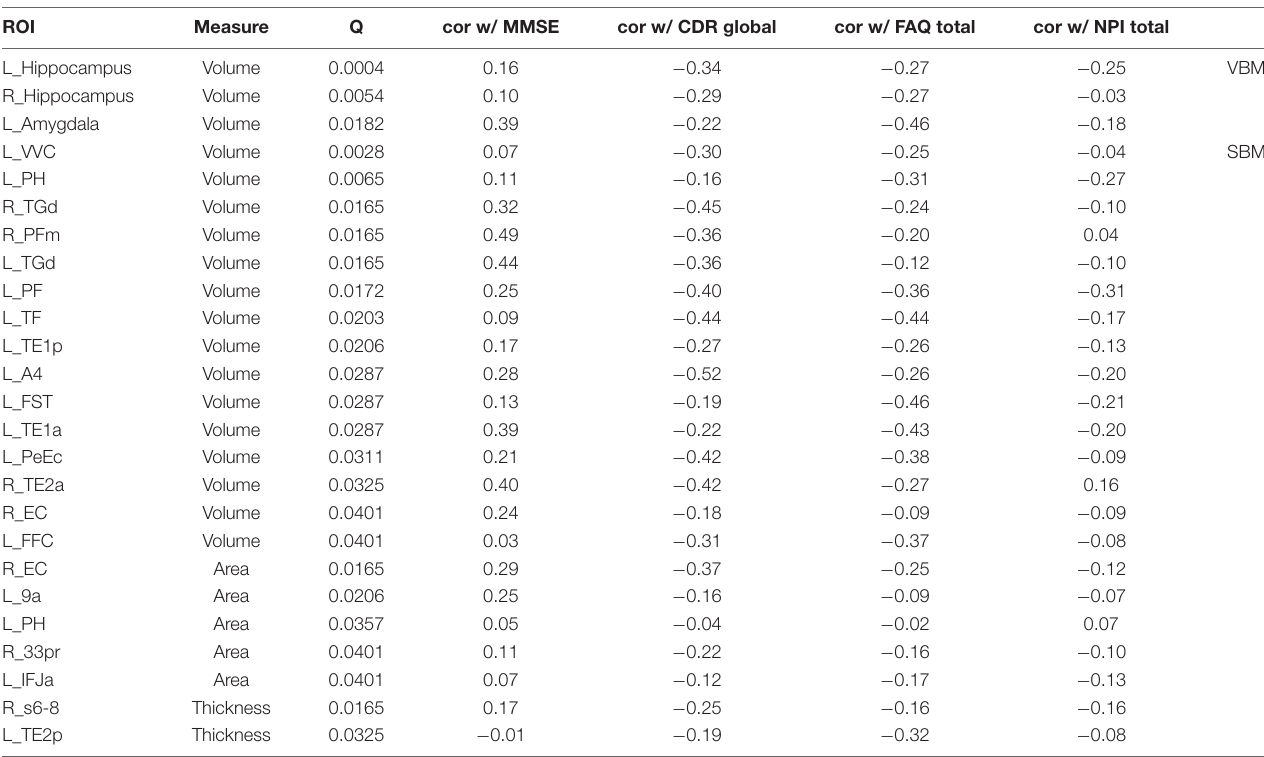
TABLE 4 | Correlation between morphometric and cognitive